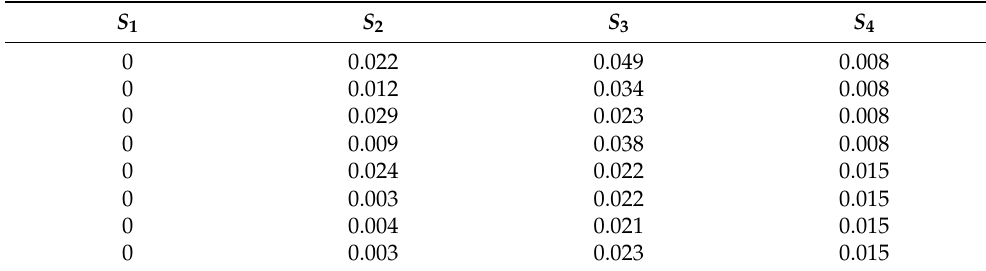
Table 2. An example of arrangement of features in a table for feature